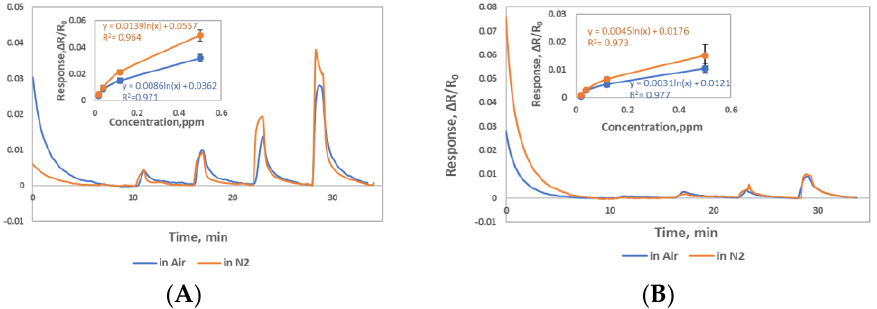
( D ) Figure 6. Responses (ΔR/R 0 ) to 0.02, 0.04, 0.12, 0.5, 1.5 ppm NO gas in 40%, 55%, 72%, 89%, 92% and 97% RH ( A ) Material 1 nanocomposite sensor response ( B ) Material 2 nanocomposite sensor re- sponse ( C ) calibration plots for Material 1 ( D ) calibration plots for Material 2. 3.3. Air and Nitrogen Environment Effect Sensing materials response to NO gas in air environment was briefly studied. Gas vendor provides NO cylinders always balanced with nitrogen due to reactivity of NO in oxygen environment. In presence of oxygen, NO converts to NO 2 gas. For this reason, all our experiments were caried out in nitrogen environment. However, we wanted to check